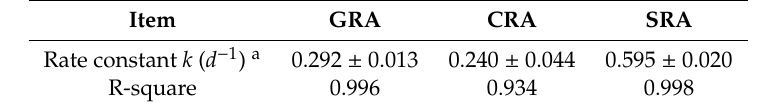
Table 2. Comparison of the cleavage rate constants and cecB2 yields for INT with various OCVs. Item